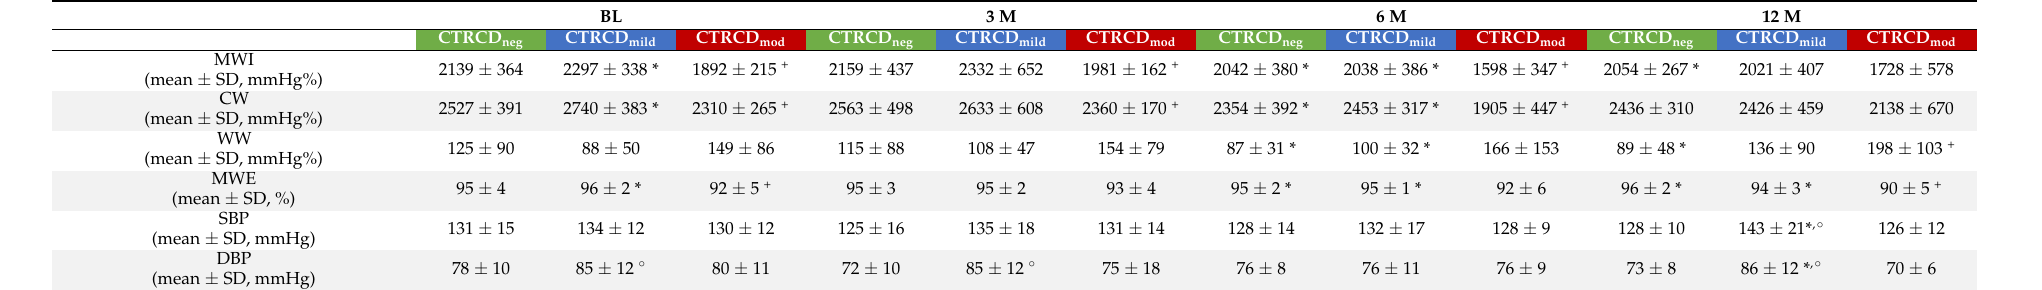
* vs. CTRCD mod , ◦ vs. CTRCD neg , + vs. CTRCD neg+mild , p ≤